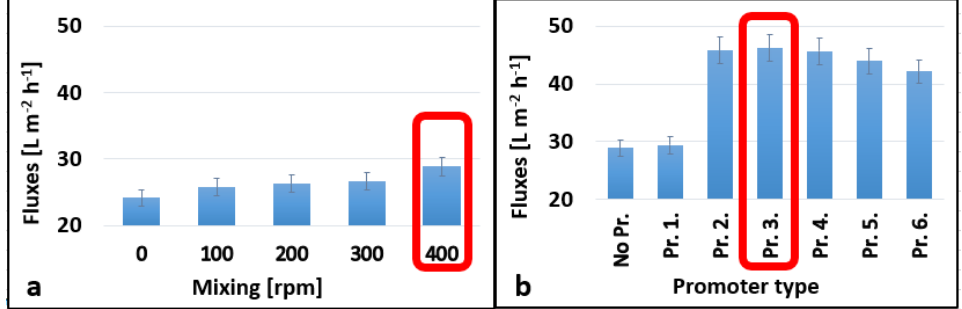
Figure 3. Effect of mixing speeds without 3DP turbulence promoters ( a ) and different promoters at 400 rpm mixing speed ( b ) on the average permeate fluxes for a 10 kDa NMWL UF membrane. A temperature of 25 °C and 4 bar transmembrane pressure (TMP) were applied during the experiments.